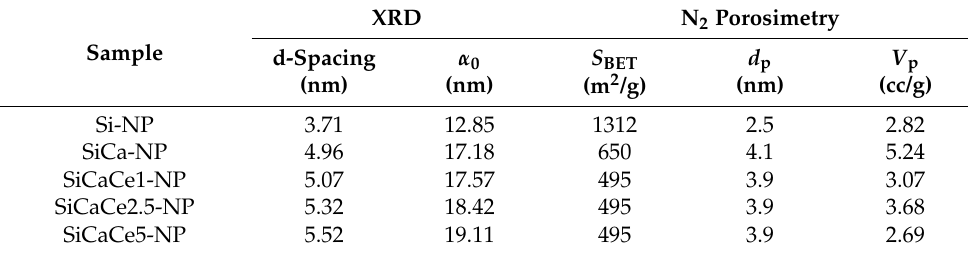
Table 4. Structural and textural properties of